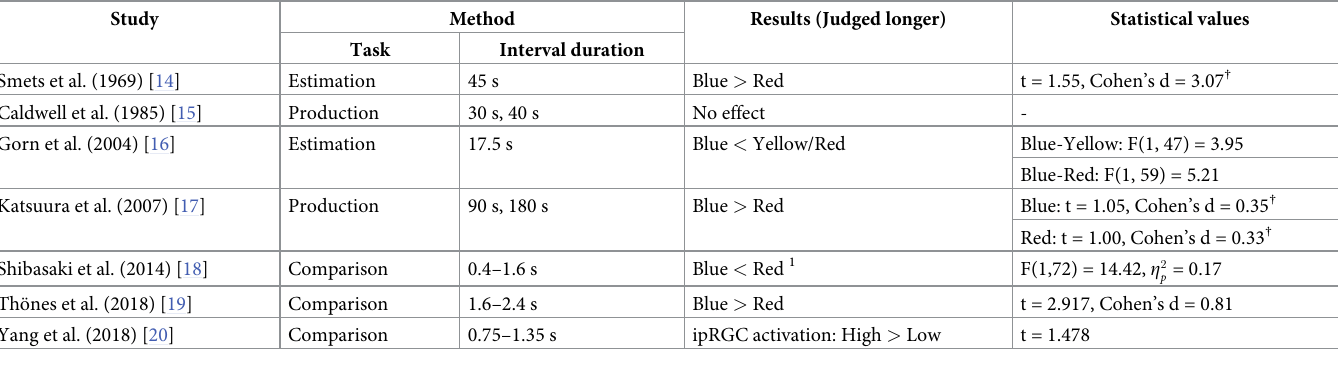
Table 1. Summaries of studies on the effect of red/blue colors on temporal perception (modified after Yang et